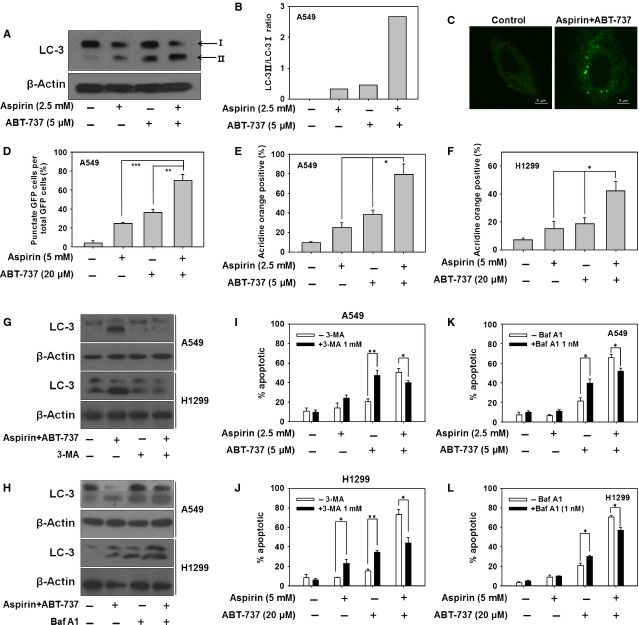
Short-term combination treatment with aspirin and ABT-737-induced autophagy. (A) A549 cells were exposed to aspirin (2.5 mM), ABT-737 (5 μM) or the combination for 12 hrs, after which protein extracts were immunoblotted using LC-3. (B) LC-3 II/I ratios were significantly increased in combination treatment with aspirin (2.5 mM) plus ABT-737 (5 μM) for 12 hrs in A549 cells. (C) A549 cells were transfected with GFP-LC-3 plasmid according to manufacturer's recommendations. Twenty-four hours after transfection, cells were exposed to aspirin (2.5 mM), ABT-737 (5 μM) or the combination for 12 hrs. Aspirin plus ABT-737 induced GFP-LC3 dot formation in A549 cells; scale bar = 5 μm. (D) Quantified results of punctate GFP-LC3/A549 cells undergoing aspirin and/or ABT-737 treatment were measured (mean ± SD, n = 3). ***P < 0.001, **P < 0.01. A549 (E) and H1299 (F) cells treated with compounds for 12 hrs were stained with AO and analysed by flow cytometry. (G) A549 and H1299 cells were pre-treated with 1 mM 3-MA for 1 hr and incubated with aspirin and ABT-737 at the indicated concentrations for 12 hrs, after which protein extracts were immunoblotted using LC-3. (H) A549 and H1299 cells were pre-treated with 1 nM Baflomycine A1 for 1 hr and incubated with aspirin and ABT-737 at the indicated concentrations for 12 hrs, after which protein extracts were immunoblotted using LC-3. A549 (I) and H1299 (J) cells were pre-treated with 1 mM 3-MA for 1 hr and incubated with aspirin and/or ABT-737 at the indicated concentrations for 48 hrs. Percentages of apoptotic cells were determined by PI analysis. A549 (K) and H1299 (L) cells were pre-treated with 1 nM Baflomycine A1 for 1 hr and incubated with aspirin and/or ABT-737 at the indicated concentrations for 48 hrs. Percentages of apoptotic cells were determined by PI analysis.